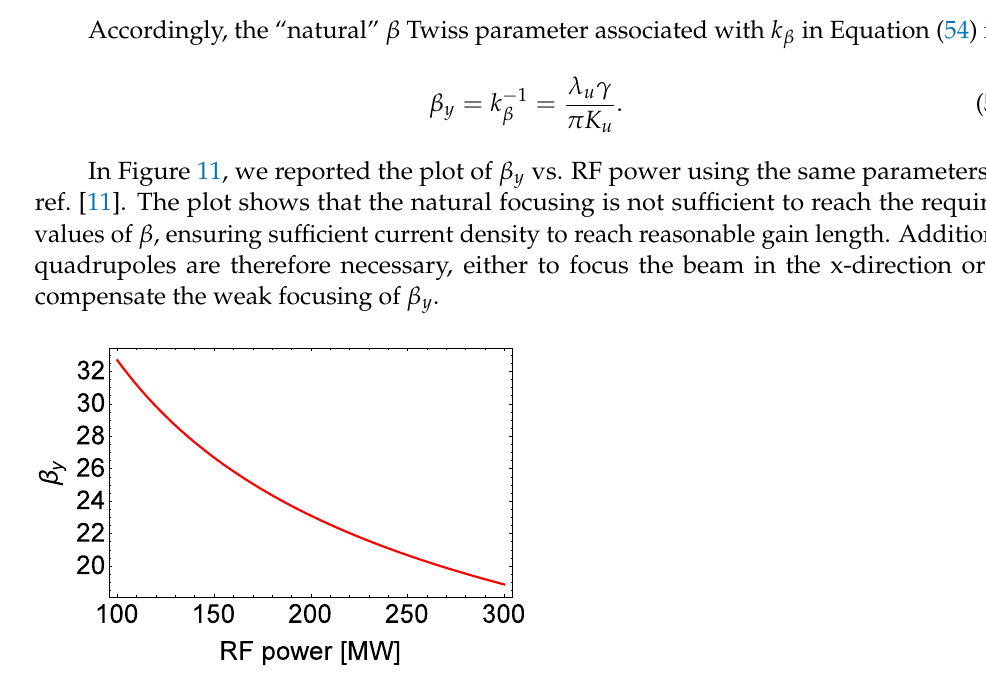
Figure 11. Twiss parameter β y vs. RF power for E = 0.7 GeV, a = b = 1.8 cm, x = 1/